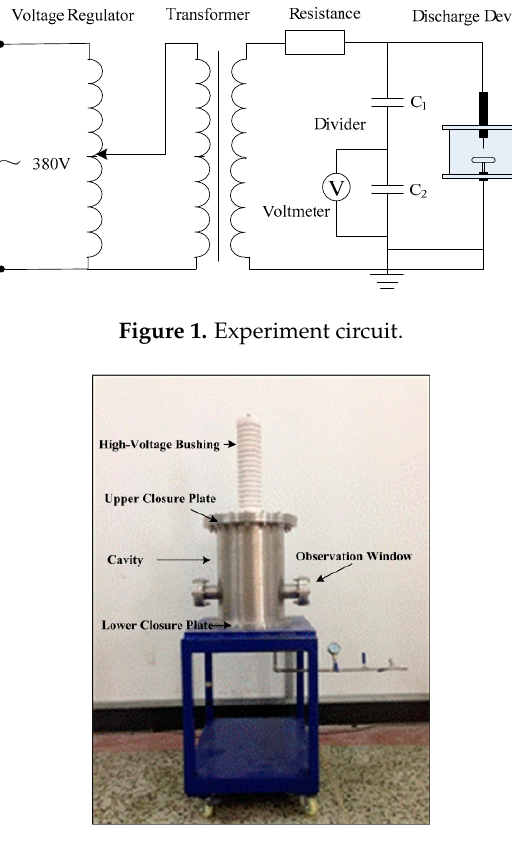
Figure 1. Experiment circuit. 86